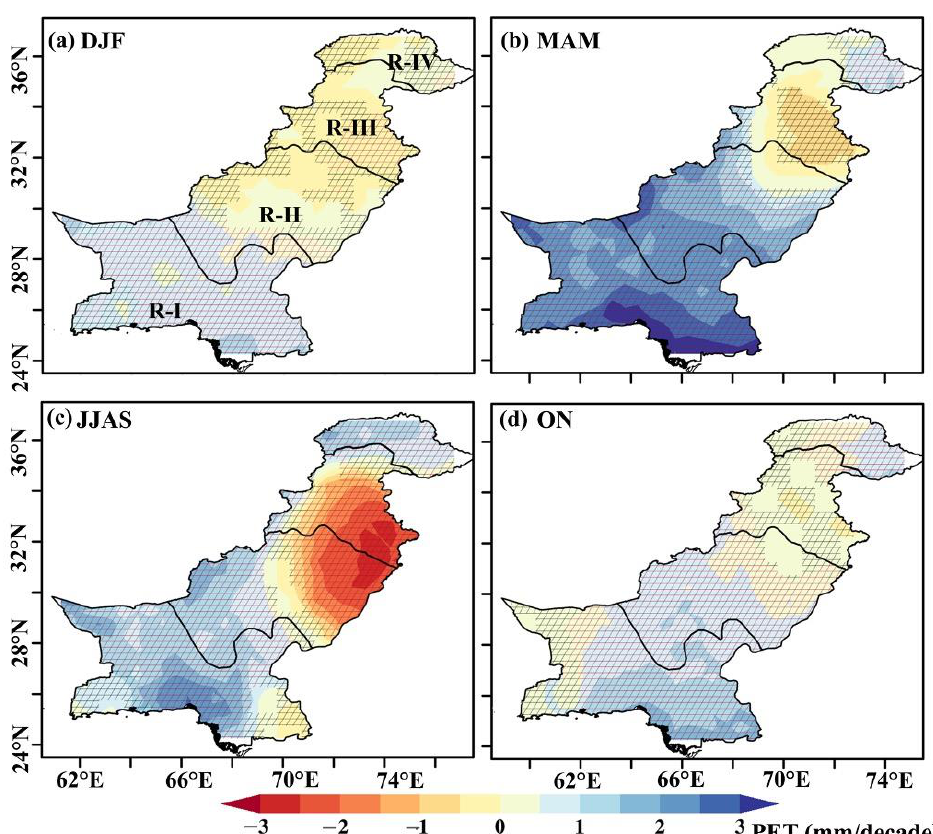
Figure 8. Spatial distribution of Mann–Kendal trend (mm/decade) of Potential Evapotranspiration (PET) during the ( a ) DJF (December to February), ( b ) MAM (March to May), ( c ) JJAS (June to September), and ( d ) ON (October to November) Season over the China Pakistan Economic Corridor for 1980–2018. The hatched area shows a statistically significant trend at a 90% confidence level. R-I, R-II, R-III, and R-IV represent the hyper-arid, arid, humid and glacial regions, respectively. Increasing temperature generally leads to increased evaporative demand [84,85].